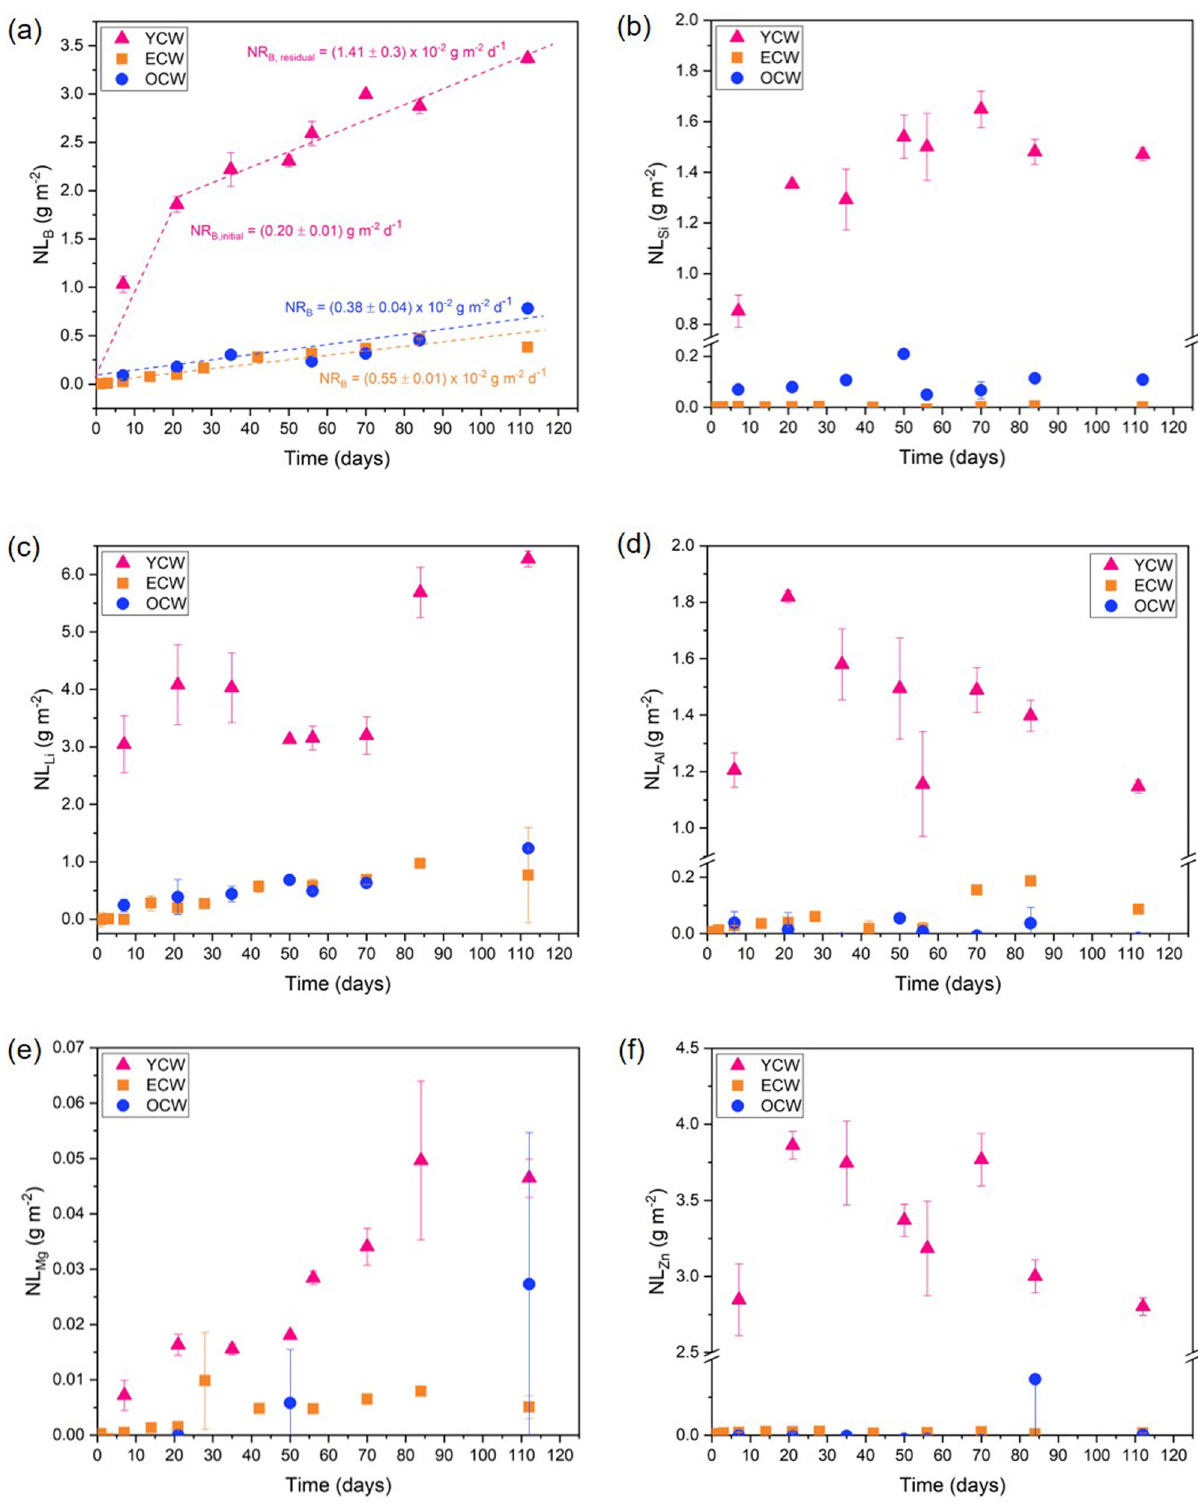
Fig. 1 Normalised mass loss (NL) of elements for CaZn28 glass dissolved in synthetic cement waters (YCW, ECW and OCW) at 50 °C for 112 d, at a glass surface area to solution volume ratio of 1200 m − 1 . a NL B , highlighting linear fi t of the dissolution rates (NR B ); b NL Si ; c NL Li ; d NL Al ; e NL Mg and; f NL Zn . Errors represent one standard deviation of triplicate